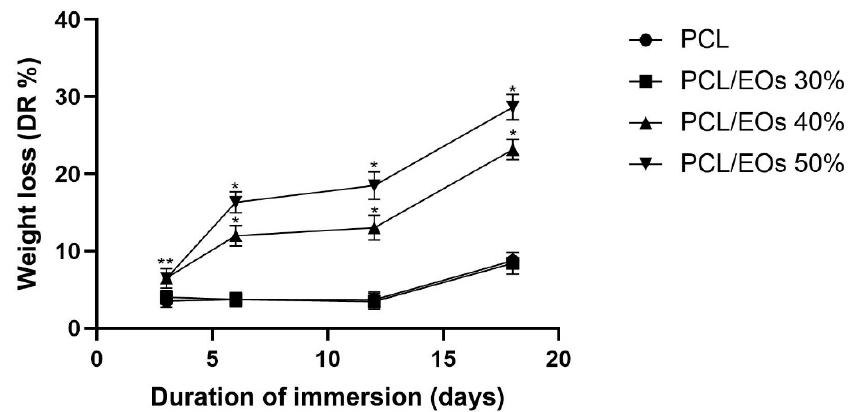
Figure 5. Weight loss, expressed as degradation rate % (DR%), of the pure PCL and EOs-added PCL-based 3D scaffolds at different time points (3, 6, 12 and 18 days) after the immersion in SBF. ** p < 0.05 or * p < 0.001 vs. PCL and 30%-added PCL based scaffolds, unpaired t -test.